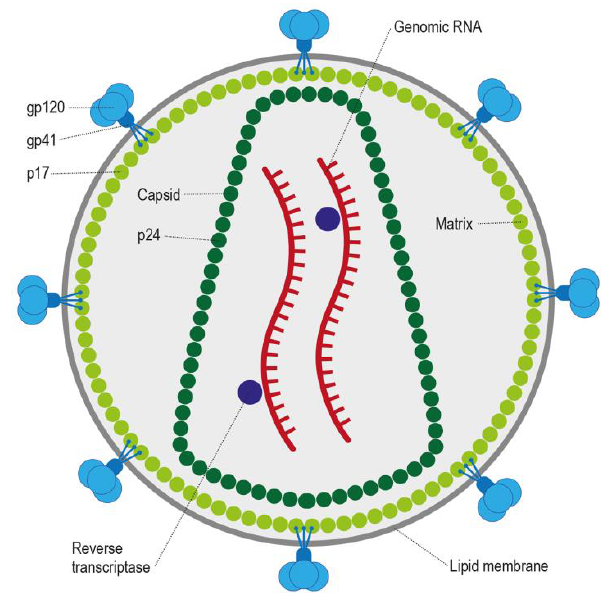
Figure 2: HIV-1 is a retrovirus that is approximately 90 – 120 nm in diameter and is enveloped by a host-derived plasma mem- brane. Trimeric envelope glycoproteins gp120/41 form the spikes on the virions surface and are embedded in the membrane. The cytoplasmic tail of gp41 interacts with the HIV-1 matrix protein p17. During maturation the capsid protein, p24, makes up the cone-shaped core, which contains two positive-strand RNA copies of the HIV-1 genome, the reverse transcriptase protein, as well as a number of other important host proteins